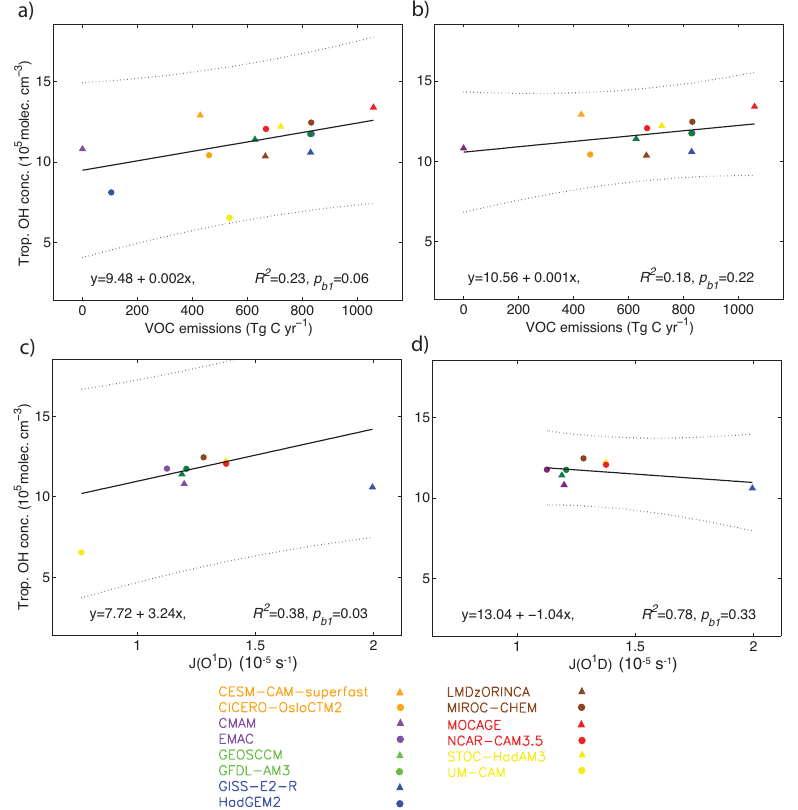
Fig. 9. Linear relationship between present day (2000) global mean tropospheric OH and (a) global NMVOC emissions, and (c) global mean J (O 1 D), across all models. The same relationship is shown after excluding the two models that did not have interactive photolysis, namely HadGEM2 and UM-CAM (b, d) . Dashed lines show the prediction intervals at a 95% confidence